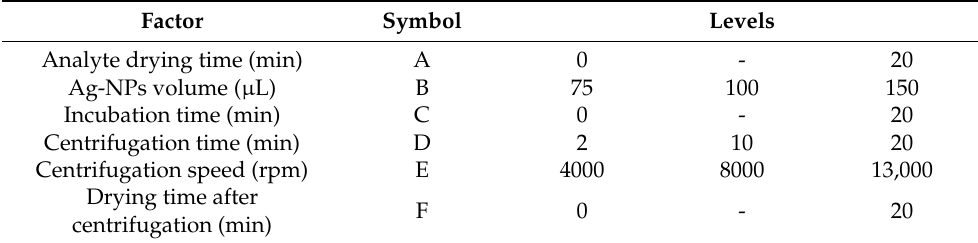
Table 1. Experimental factors and levels of D-optimal for CSPP